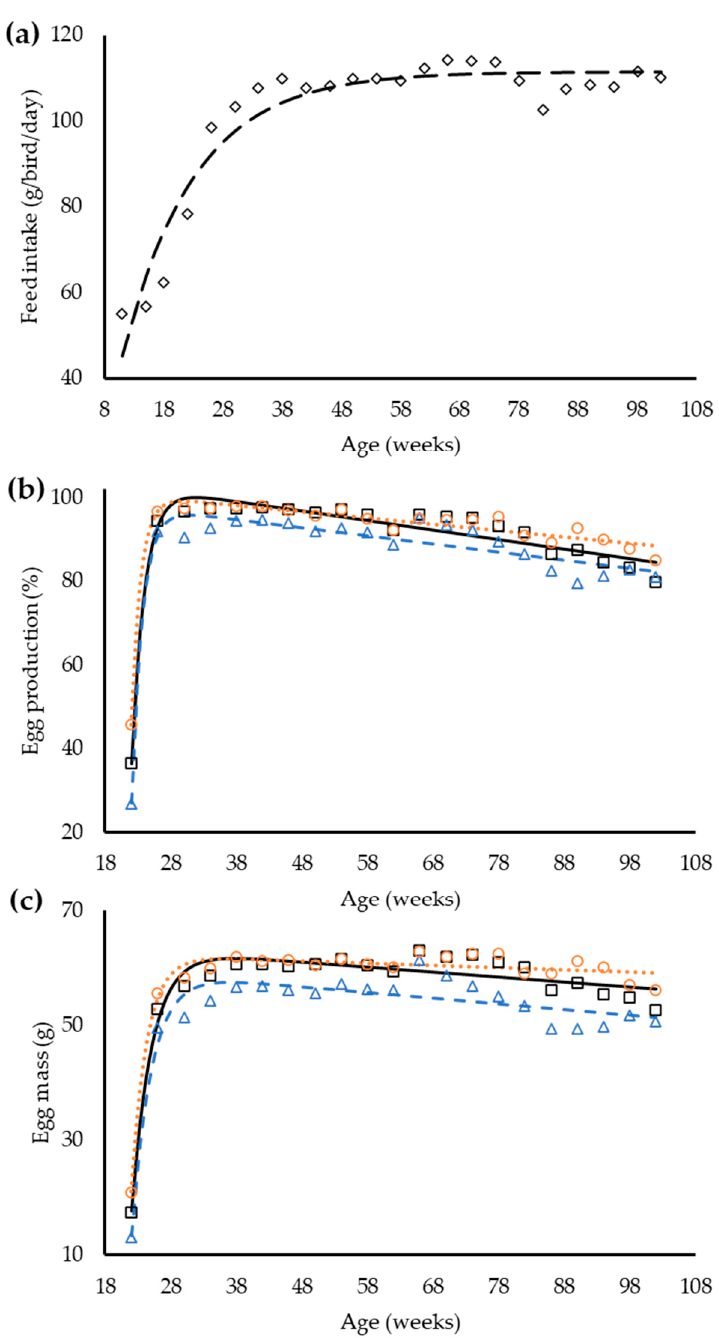
Figure 1. Observed and predicted feed intake (( a ) ◊ , – –) of laying hens from 8 to 102 weeks old and of egg production ( b ) and egg mass ( c ) of laying hens from 19 to 102 weeks old in response to age in three dietary balanced protein levels: standard ( □ , —), low ( ∆ , - -), and high ( ○ , ∙∙∙ ). Overall, egg weight of laying hens was affected by dietary balance protein content ( p < 0.05, Table 9). At 26 w-old, hens consuming the H feed produced heavier eggs, followed by hens from the S and L groups, respectively. Notably, egg weight was similar between groups of hens from 30 to 42 w-old and from 54 to 66 w-old ( p < 0.05). The yolk percentage increased in all feed treatments as the hens aged ( p <